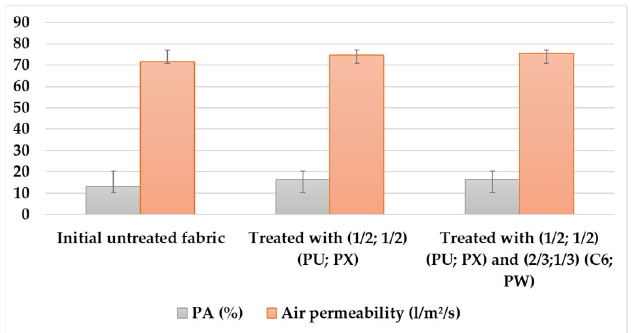
Figure 14. Variation of the adiathermic power PA (%) and the air permeability (L/m²/s) of the initial untreated fabric, the sample treated with (1/2; 1/2) (PU; PX), and the sample treated with the final optimized combination (1/2; 1/2) (PU; PX) and (2/3; 1/3) (C6; PW).